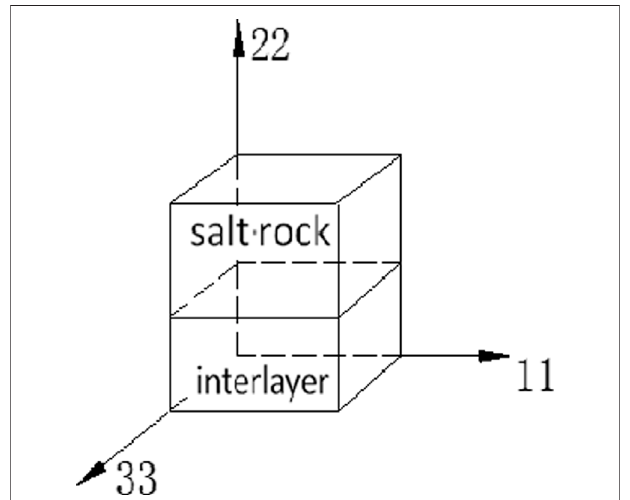
FIGURE 3 | Representative volume element for interbedded salt rock (Wang et al.,